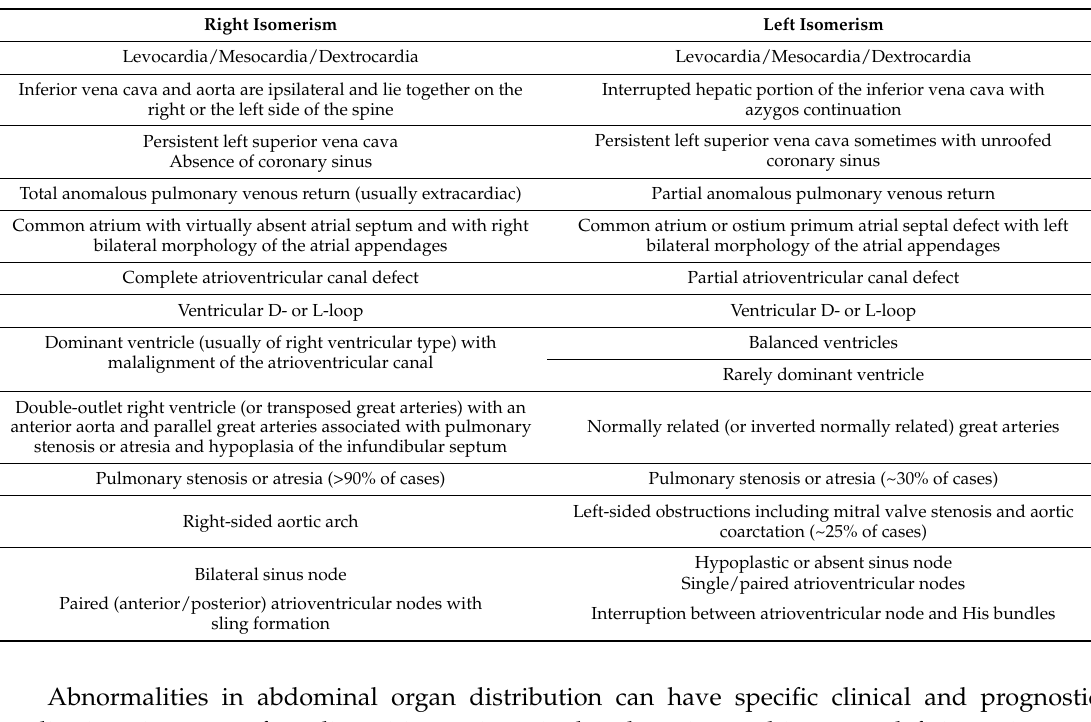
Table 1. Cardiovascular malformations in